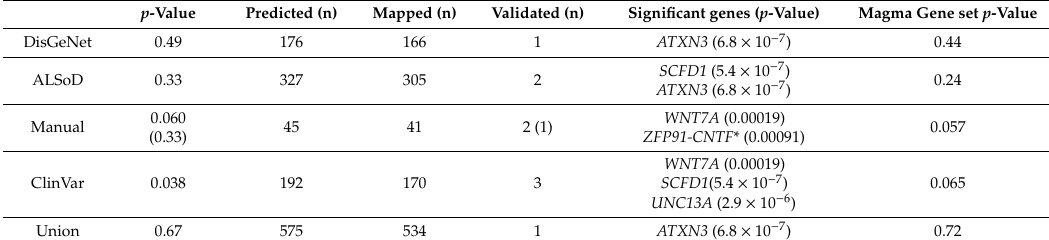
Table 5. Validation of predicted ALS-linked genes. * ZFP91-CNTF is a read-through transcript of both ZPF91 and CNTF . CNTF was predicted to be ALS-linked by the model. The p -value and number of validated genes shown in brackets indicate results if the ZFP91-CNTF transcript is not considered. p -Value Predicted (n) Mapped (n) Validated